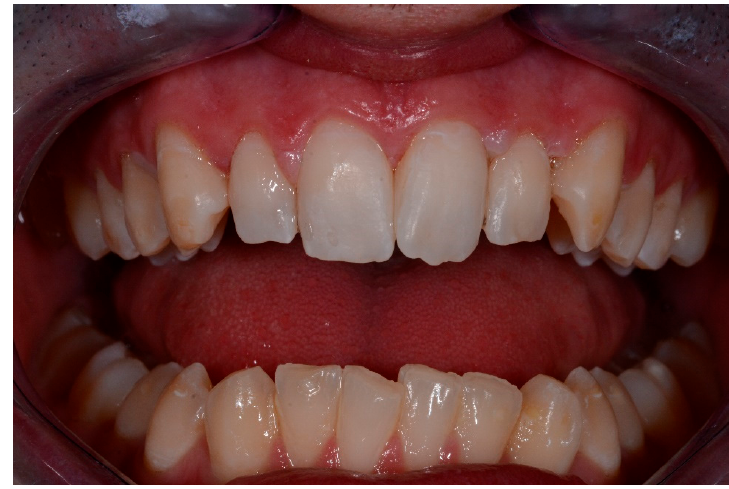
Figure 3. Finishing and final results .